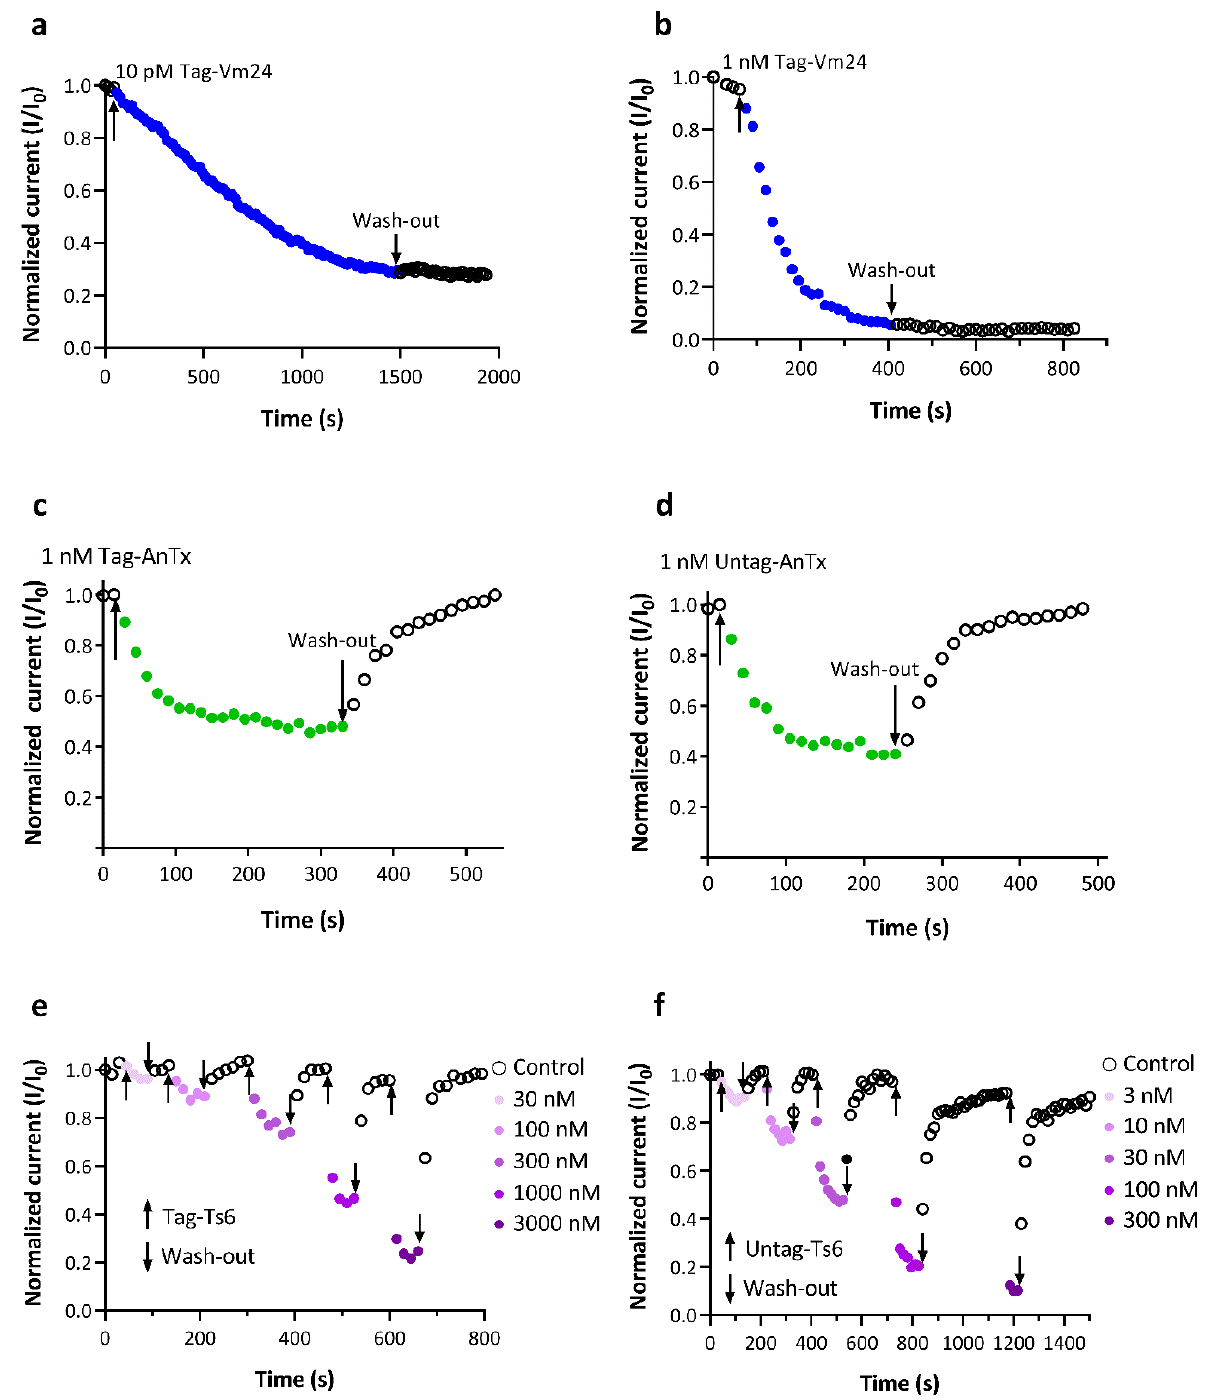
Figure 5. Blocking kinetics of recombinant Vm24, AnTx, and Ts6 on hKv1.3. Whole-cell currents through hKv1.3 were evoked from activated human peripheral T lymphocytes by depolarization to +50 mV from a holding potential − 120 mV for 15 ms duration. Test pulses were applied every 15 s. Time courses of the development and recovery of the hKv1.3 current inhibition are shown for each peptide. Normalized peak K + currents (I/I 0 ) were determined and plotted as a function of time. Down and up arrows indicate the start and the end of perfusion with the recombinant peptide containing solution or toxin-free solution, respectively. Data points in blue, green, or purple shades represent the addition application of recombinant Tag-Vm24 (panel ( a , b )), AnTx (panel ( c , d )), and Ts6 (panel ( e , f )), respectively, in their tagged or untagged version, as indicated.